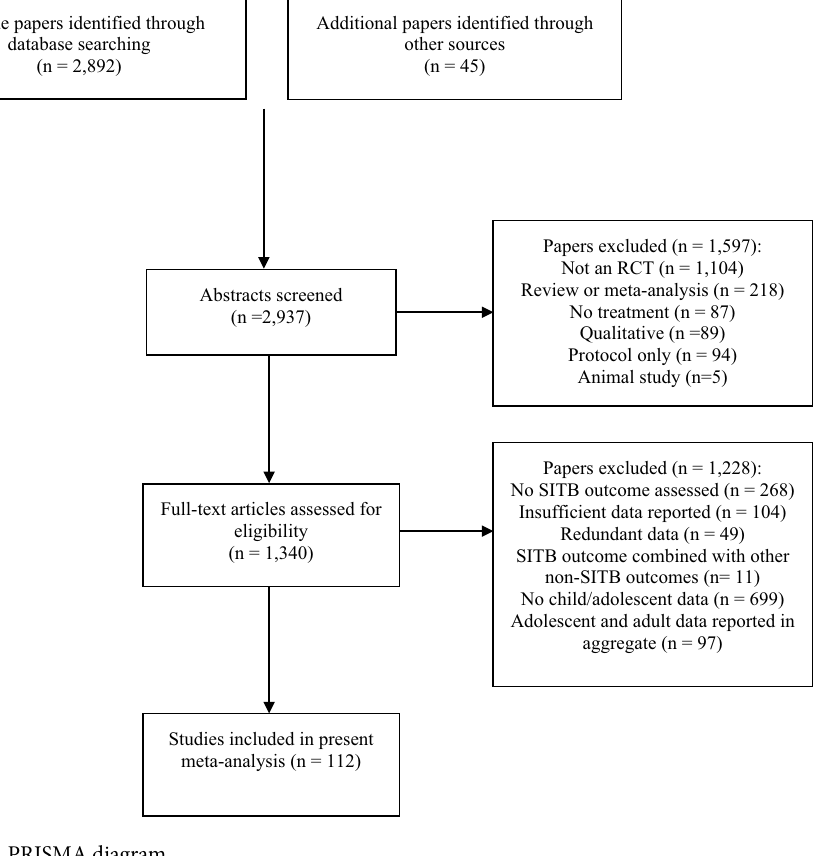
Figure 1. PRISMA